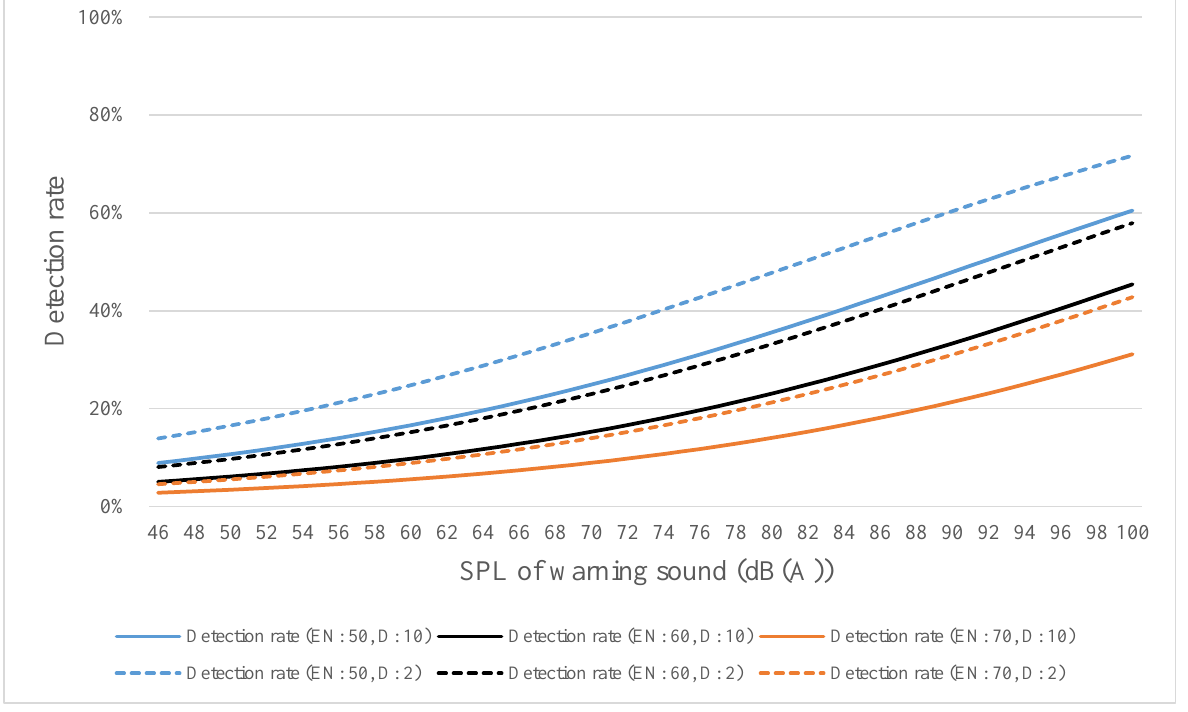
Figure 12. Estimated detection rate for low-frequency warning sound as calculated using Equation (6) (EN denotes environmental noise; D denotes distance). Table 3. Estimated SPL (dBA) of high-frequency warning sound.